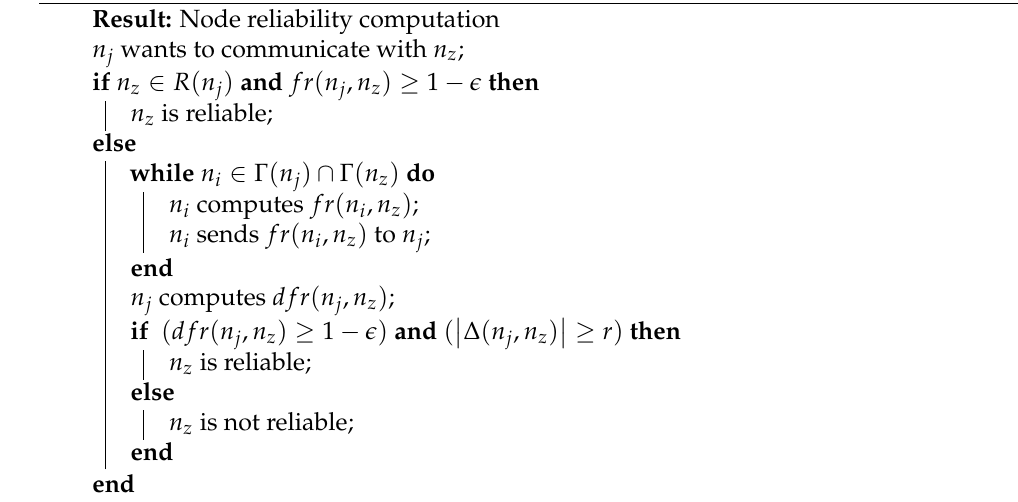
Algorithm 1: Algorithm for object-to-object reliability computation Result: Node reliability